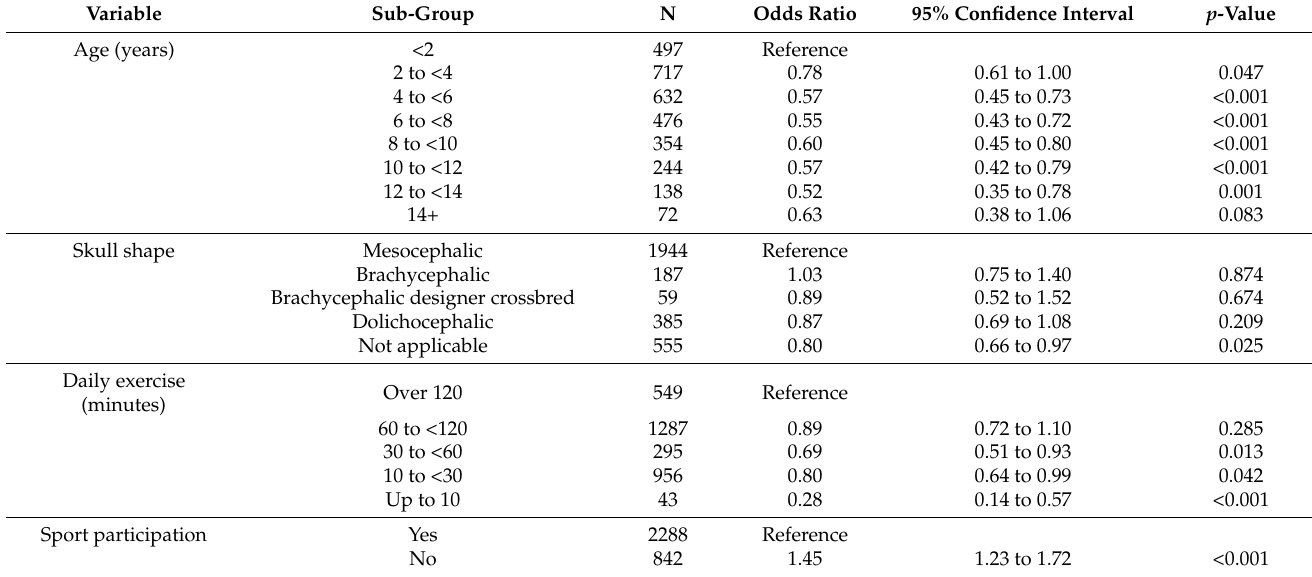
Table 8. Mitigation model 2, use of cooling after exercise in summer: canine variables tested through binary logistic regression for their association with coat use in winter to facilitate activity. Increased odds of coat use are indicated by an odds ratio greater than one; an odds ratio lower than one indicates reduced odds of coat